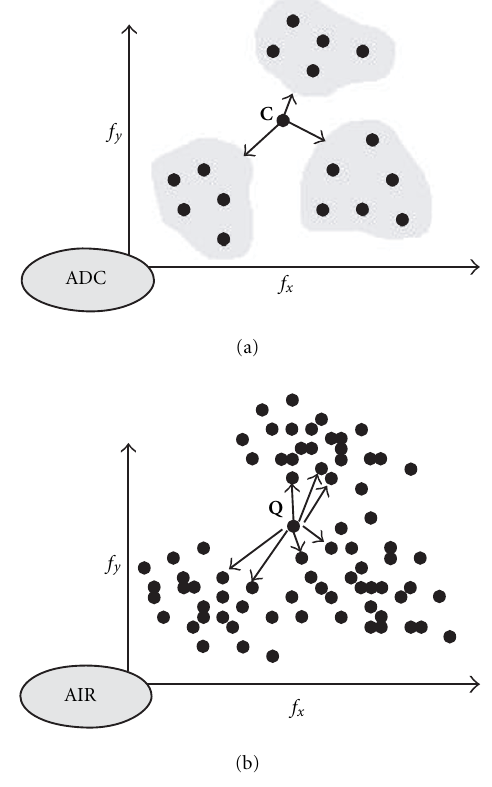
Figure 6: A feature-space comparison of (a) ADC versus (b) AIR. In (a) the query point C is a point to be classified by the ADC system whereas in (b) the data query Q is a query upon which to perform image